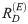
(A) The mutual information rate of the release site as a function of the memory length of the channel, L, for different values of depression coefficients. Three different seed values, u0, are used in the algorithm in Fig 1B to measure the effective memory of the depressing synapse. (B) The mutual information rate (solid lines), RD, and the energy-normalized information rate (dashed lines), RD(E), as a function of input spike rate, α, for various depression coefficients, c and d. The black lines connect the maximum values of the curves. The other parameters of the model are p0 = 0.7, q0 = 0.1 and e = f = 0.1. In (A), α = 0.3, and in (B), L = 20.